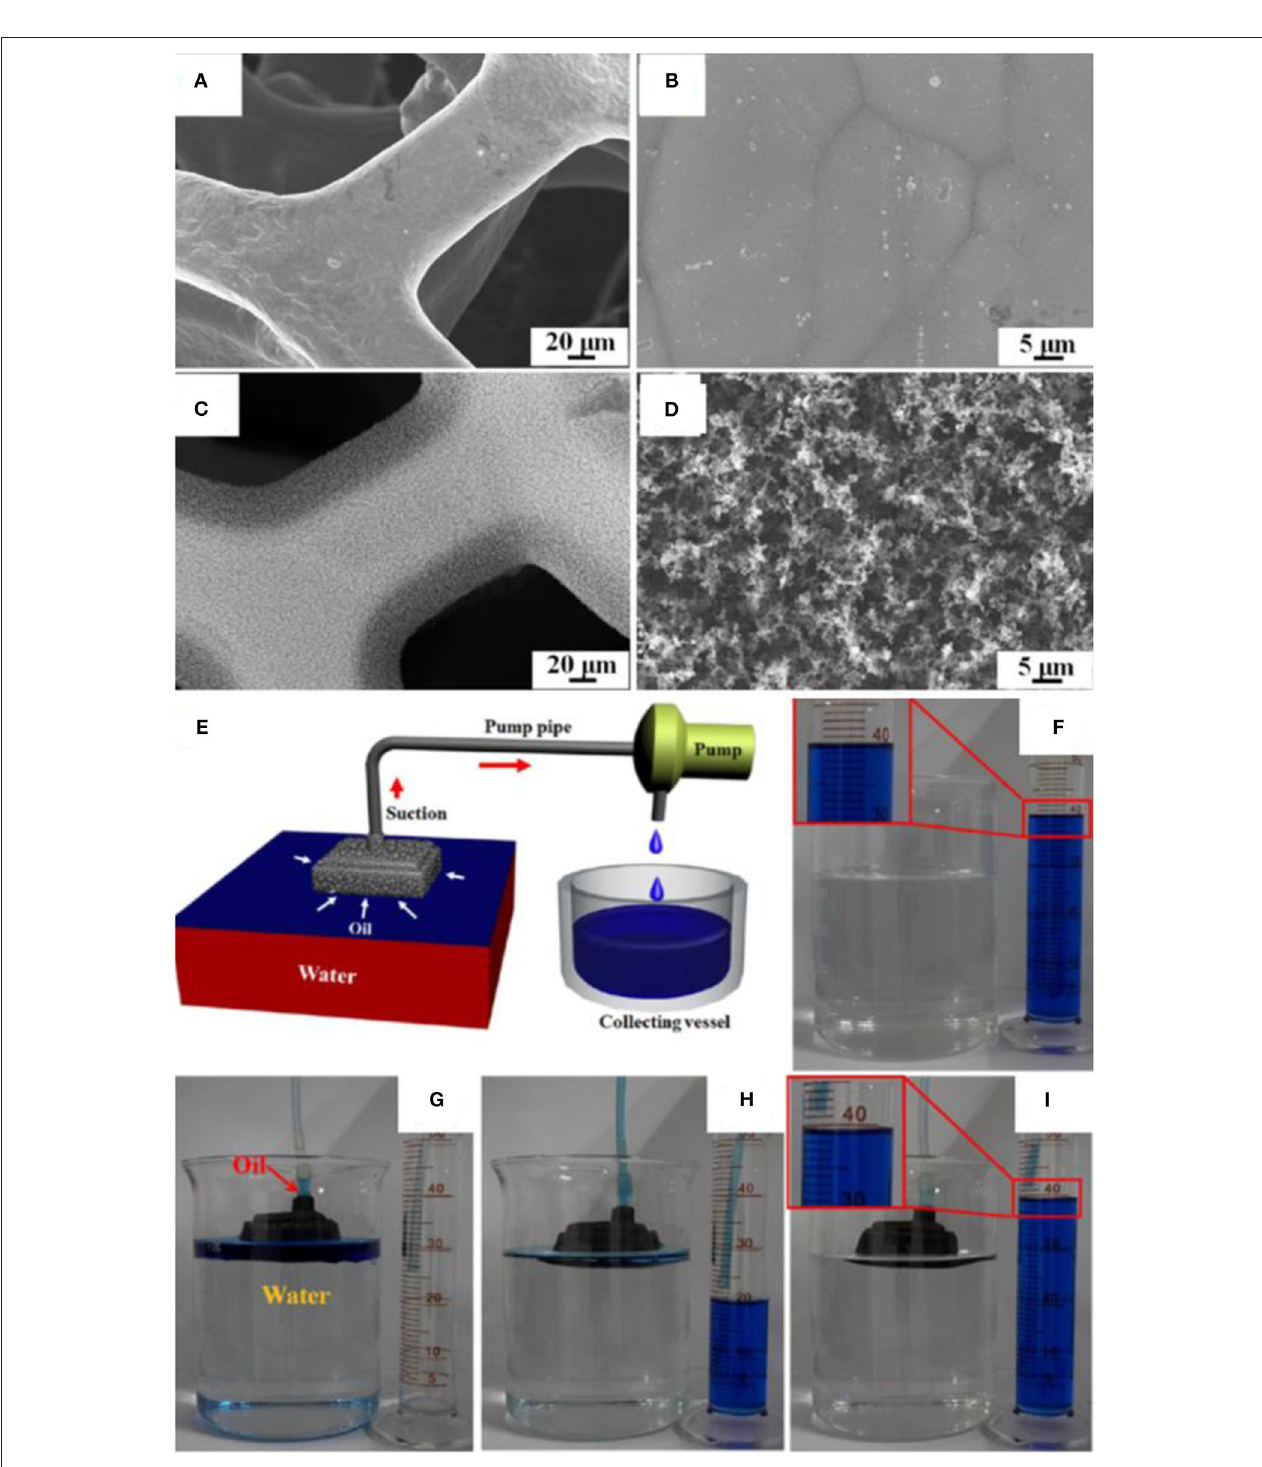
FIGURE 12 | (A,B) SEM images of copper foam before and (C,D) after coating with candle soot. (E) Schematic showing the separation apparatus. (F–I) Digital images showing the separation of oil/water mixtures by using superhydrophobic copper foam. Adapted from Ju et al. (2017). With permission from the American Chemical Society, copyright